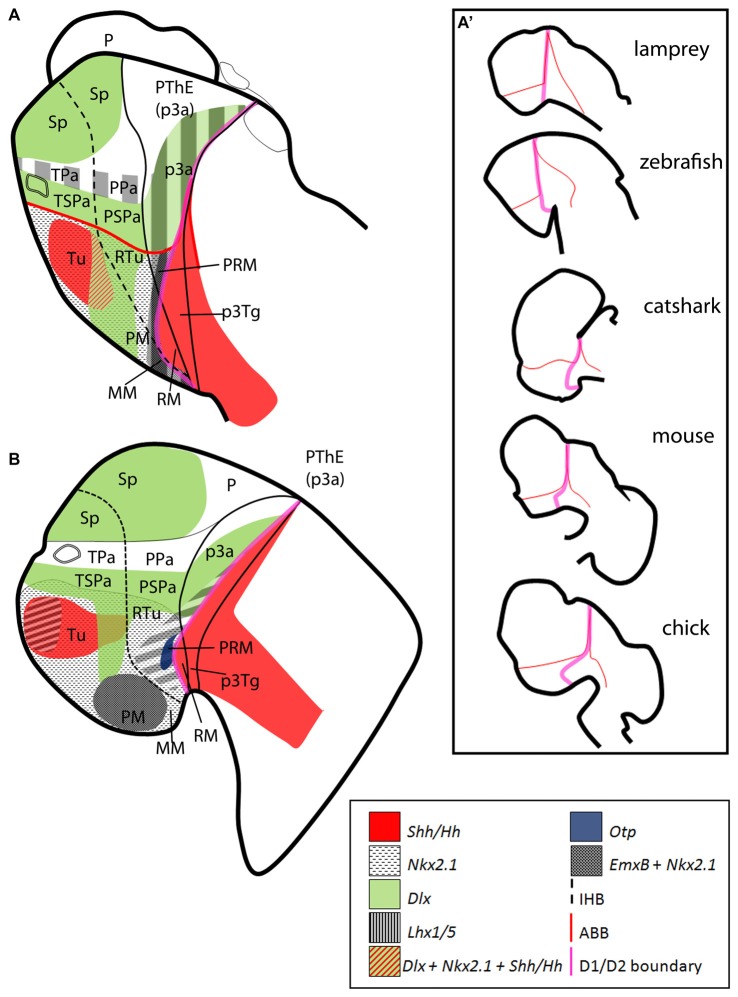
Sagittal schematic representations of the expression patterns of some orthologs here considered in (A) lamprey (adapted from Martínez-de-la-Torre et al., 2011) and (B) zebrafish (adapted from Hauptmann and Gerster, 2000). Schemes represent parasagittal sections at mid development. (A′) Conserved expression patterns suggest an alternative segmental border (pink line), which become deformed through evolution (adapted from Moreno and González, 2011). Data based on the following literature: (A) Murakami et al. (2001); Myojin et al. (2001); Ogasawara et al. (2001); Uchida et al. (2003); Osorio et al. (2005); Osório et al. (2006); Guérin et al. (2009); Tank et al. (2009); Kano et al. (2010); Martínez-de-la-Torre et al. (2011); Sugahara et al. (2011); (B) Barth and Wilson (1995); Hauptmann and Gerster (2000); Mathieu et al. (2002); Kapsimali et al. (2004); Jeong et al. (2006); Filippi et al. (2007, 2012); Ryu et al. (2007); Del Giacco et al. (2008); Osório et al. (2010); Yang et al. (2012); Lauter et al. (2013); Wolf and Ryu (2013); Manoli and Driever (2014). For abbreviations, see list.